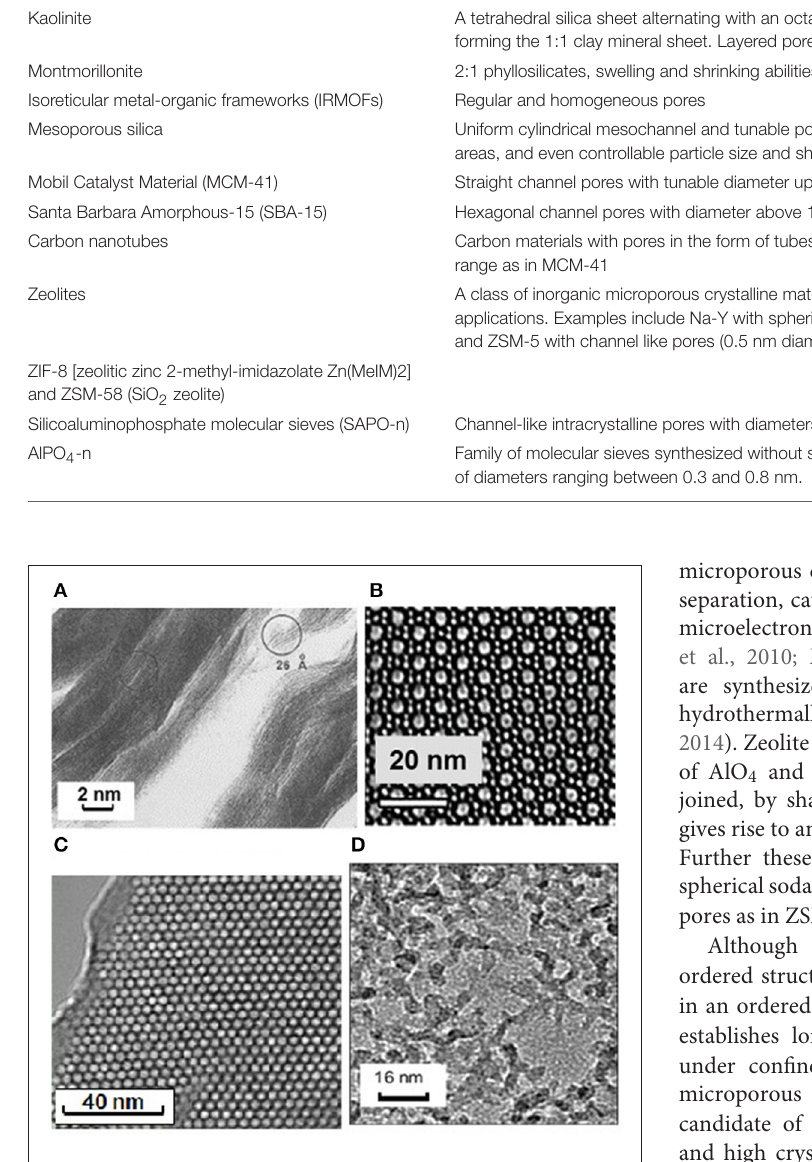
FIGURE 1 | Transmission electron microscope (TEM) images of some porous materials with well-ordered pore structures (A–C) or an irregular pore network (D) . (A) Pillared clay with a layered structure leading to interlamellar porosity; (B) ZSM-5 zeolite with pores in the form of channels with diameter of 0.5 nm; (C) MCM–41 with pores in the form of channels of variable diameter; and (D) Silica aerogel with irregularly shaped